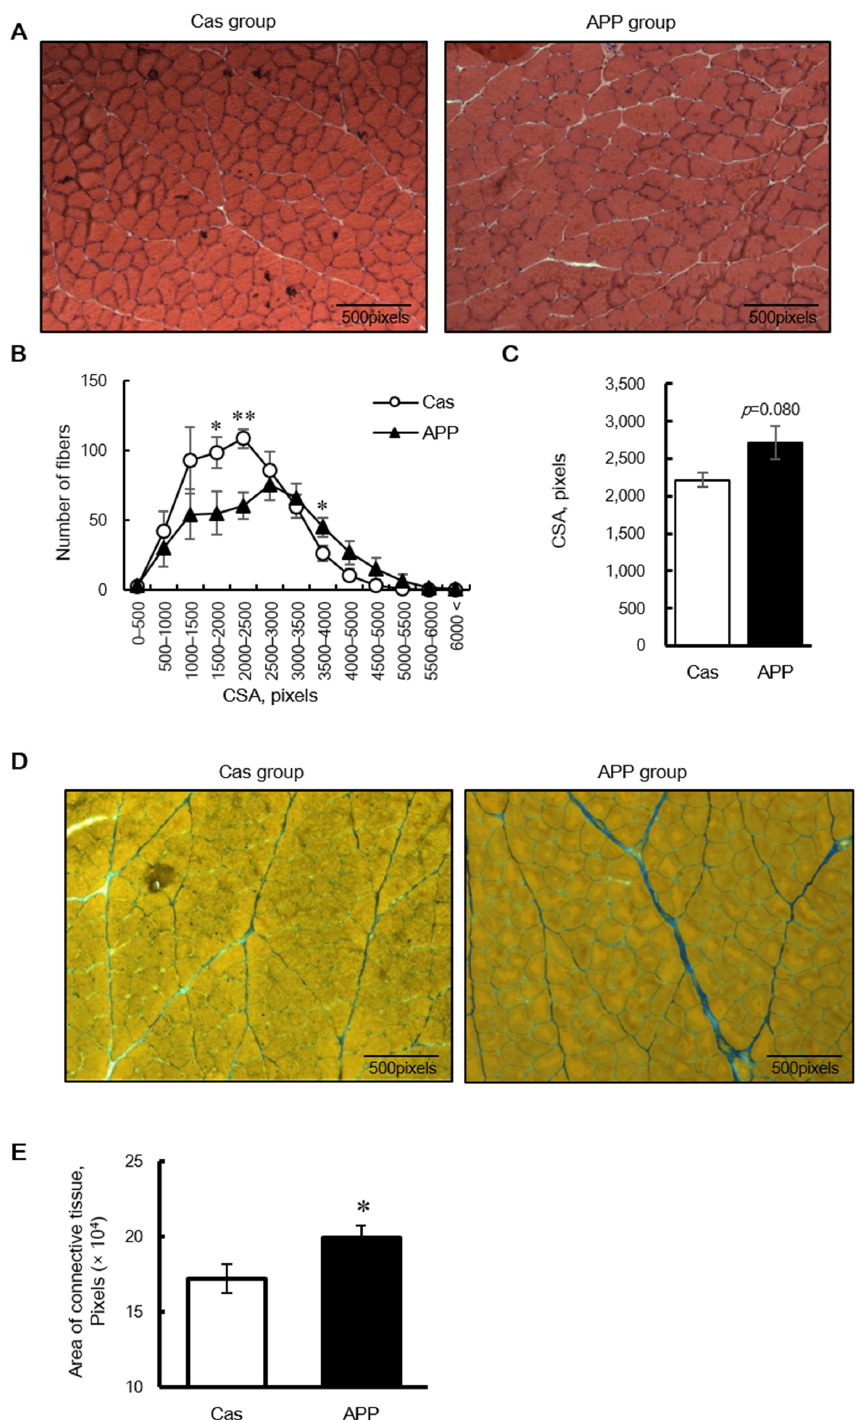
Figure 3. The cross-sectional area (CSA) in muscle fibers and connective tissue in the gastrocnemius muscle of rats fed a normal-fat casein diet or a normal-fat Alaska pollack protein (APP) diet after 7 days of feeding. Transverse sections stained with hematoxylin-eosin ( A ), distribution of CSA ( B ), and mean fiber CSA ( C ) in the gastrocnemius muscle of normal-fat casein diet group (Cas, n = 7) and normal-fat APP diet group (APP, n = 7) and transverse sections stained with Azan ( D ) and the average area of connective tissue ( E ) in the gastrocnemius muscle of normal-fat casein diet group (Cas, n = 8) and normal-fat APP diet group (APP, n = 8) are shown. Data are expressed as the mean ± standard error (SEM). Asterisks indicate significant differences relative to the Cas group, as determined using Student’s t -test. (*, p < 0.05; **, p <